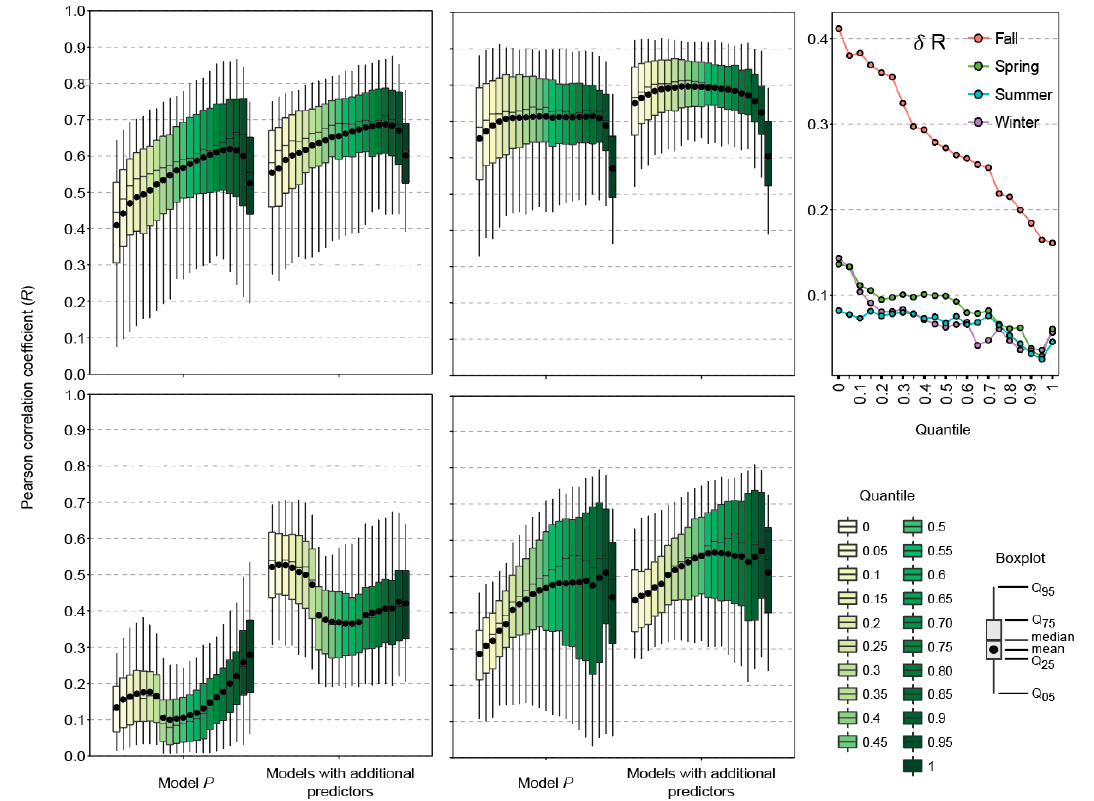
Figure 9. Influence of additional predictors on model fits. The fits are assessed here using the correlation coefficient ( R ) at all models where model P is not the best fit (18,815 model fits, across every site, flow quantile and season). The four panels indicate the four seasons: within each panel, the boxplots on the left indicate the correlation coefficient for Model P ; those on the right indicate the correlation coefficient for the best-fitting model at each site (i.e., with additional predictors). The top right panel shows the absolute difference between the correlation coefficients ( δ R ) for the best-fitting model and Model P at each site. For comparison, Figure S8 shows the same information as Figure 9 but computed with Spearman’s rho instead of Pearson’s correlation coefficient R (nonparametric equivalent). [Note that this figure indicates R for the models, not the CV.]